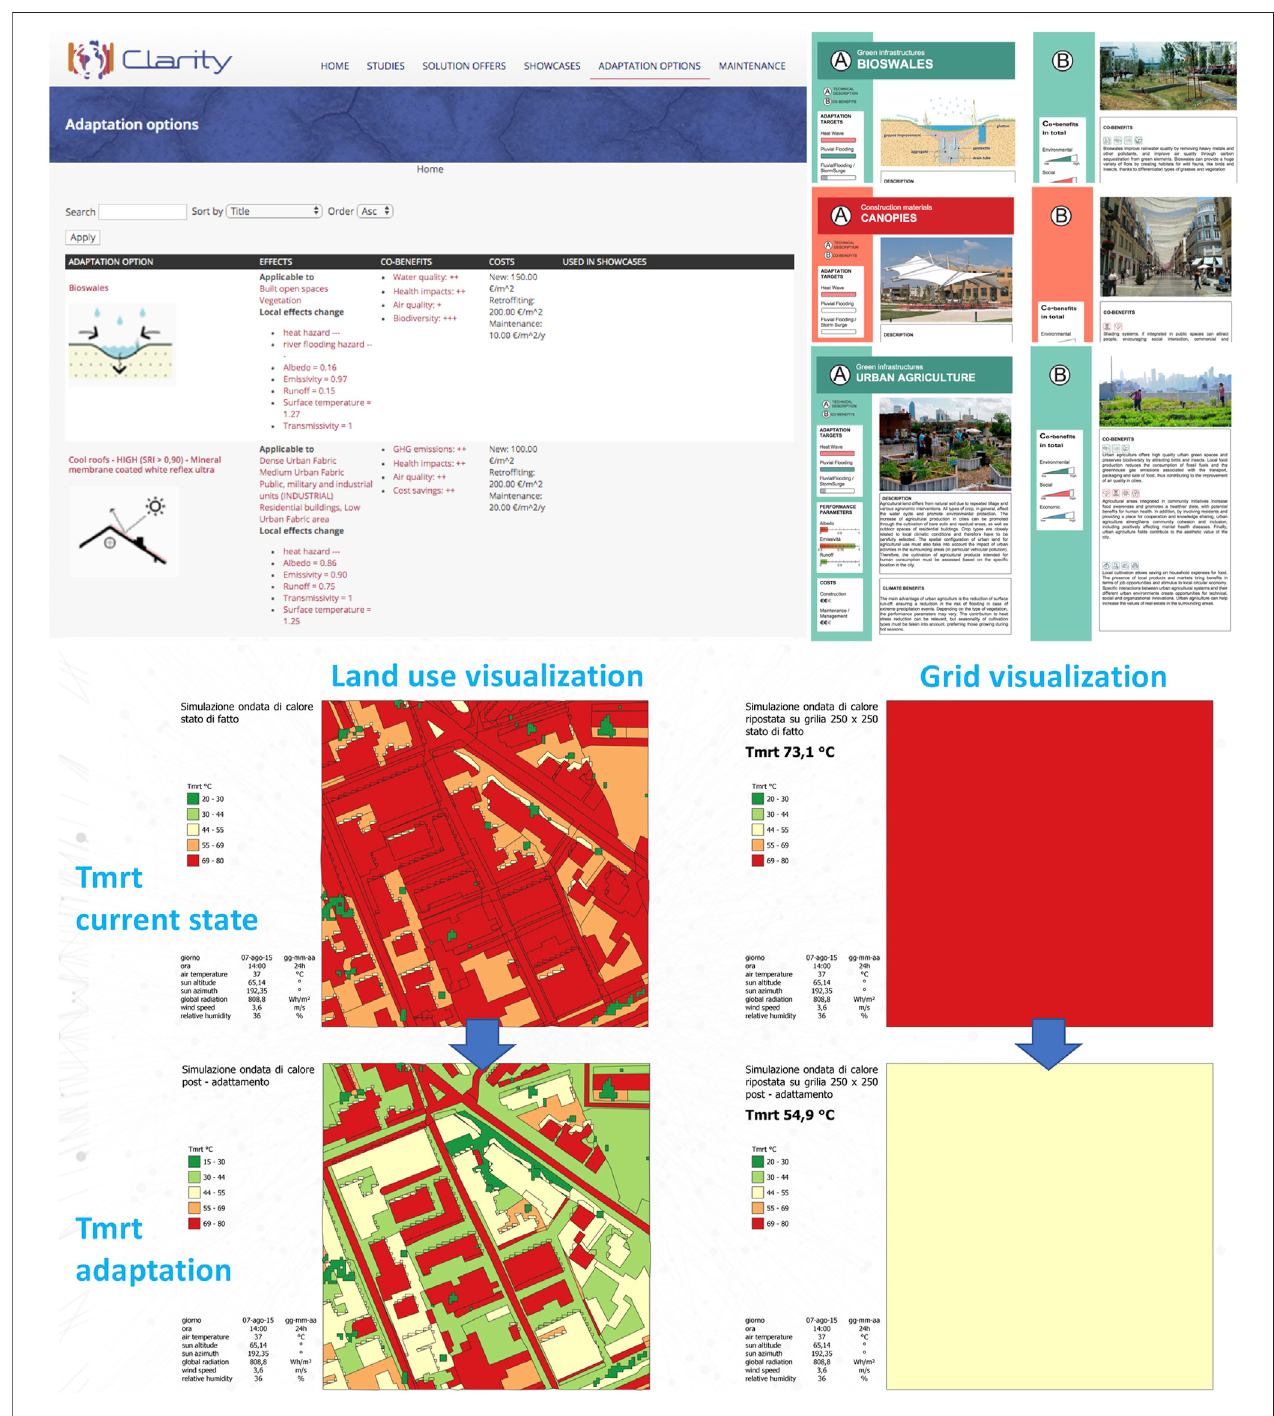
FIGURE6| CSISscreenshotforthestep “ Identifyadaptationoptions ” (top-left) andadaptationmeasures “ factsheets ” (top-right) ;anexampleofmodi fi cationof Tmrt values on a cell following the integration of adaptation strategies (bottom) .